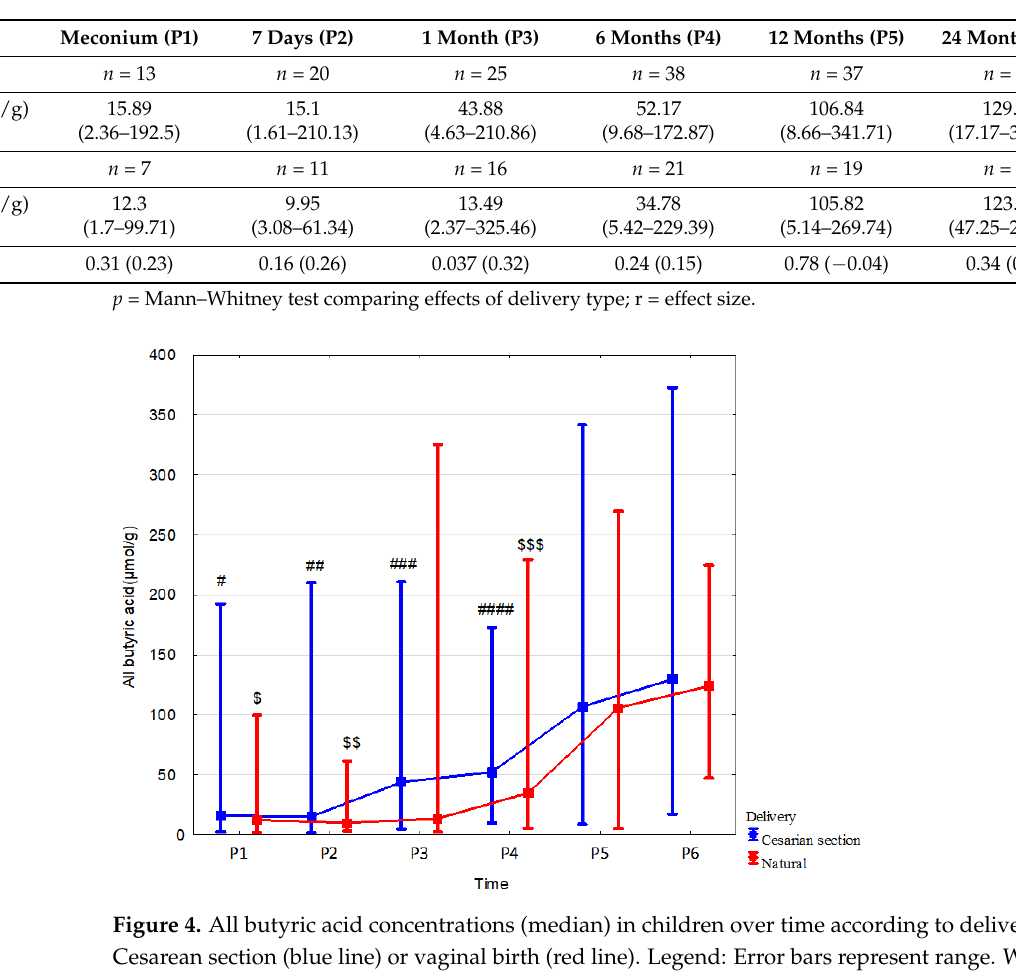
Table 5. Effects of delivery mode on fecal butyric acid concentrations.